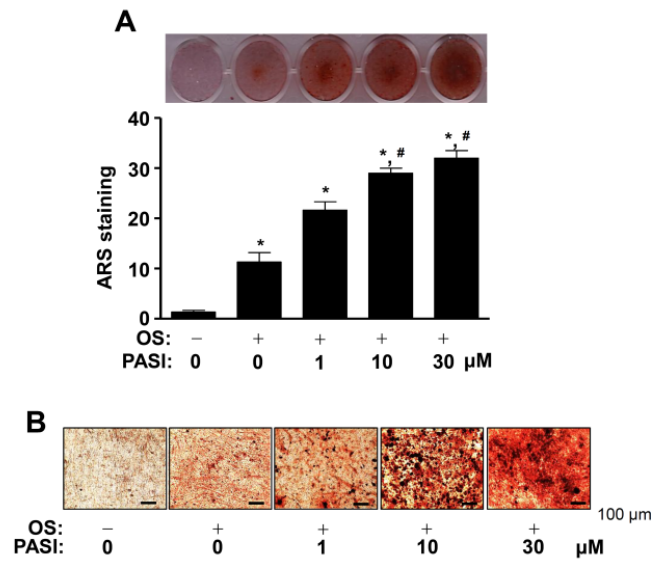
Figure 4. Effects of PASI on the staining of ARS during late osteoblast differentiation. ( A ) The staining of ARS was visualized using a scanner (upper). The quantification of ARS stains was analyzed by using a spectrophotometer and exhibited as a bar graph (bottom). ( B ) The formation of the nodules was detected under a light microscope. Data are expressed as the mean ± S.E.M. of experiments. * p < 0.05, # p < 0.05 indicate a statistically significant difference compared to the control and OS, respectively.